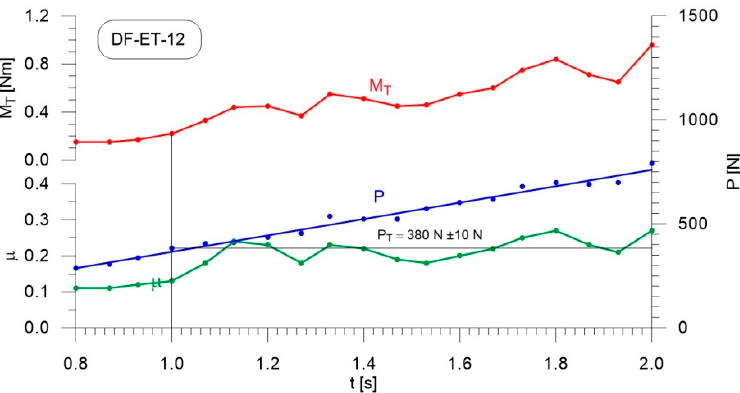
Figure 10. Courses of the load, P, the friction torque, M T , and the friction coefficient, µ, for diesel–